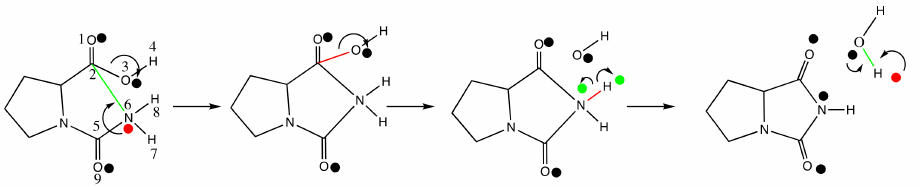
Figure 11. ELF basin isosurfaces ( η = 0.7) of each of the SSDs found along the IRC associated with TS4-b . Color labeling of the basins is adopted according to Figure S3.